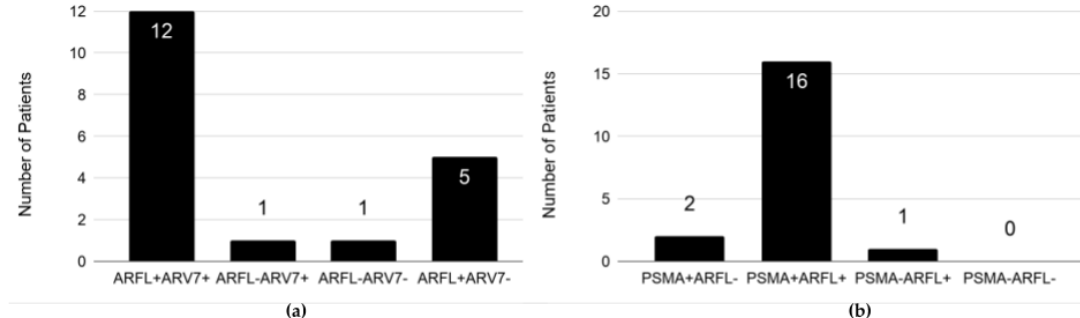
Figure 3. ARFL, ARV7 and PSMA expression in EpCAM + CTCs of mCRPC patients at progressive disease (PD): ( a ) ARFL and ARV7 expression and ( b ) PSMA and ARFL expression. The number in each